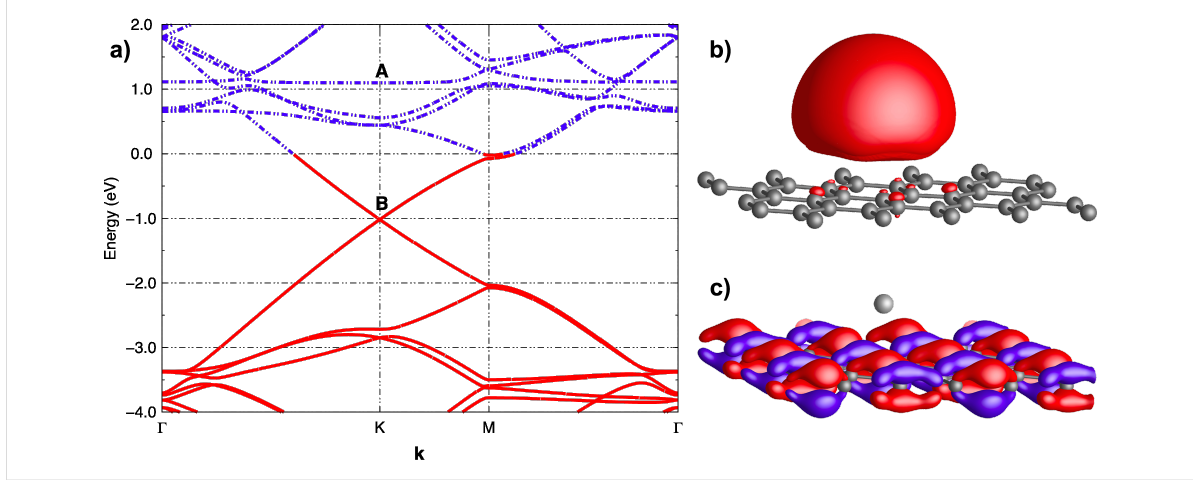
Figure 3: a) Electronic band structure (eV) of a K atom on top of a graphene layer in the vicinity of the Fermi energy. The Fermi level is set to zero. Full lines denote occupied states while dashed lines show empty levels. The bands around B , unoccupied for pristine graphene, are now occupied. b,c) Plots of the real part of the wavefunctions of electronic levels marked A and B in the electronic band structure of K on top of graphene. The wave- function of the level marked A is localized on the K atom while the wavefunction of the highest occupied level, marked B , is delocalised over the